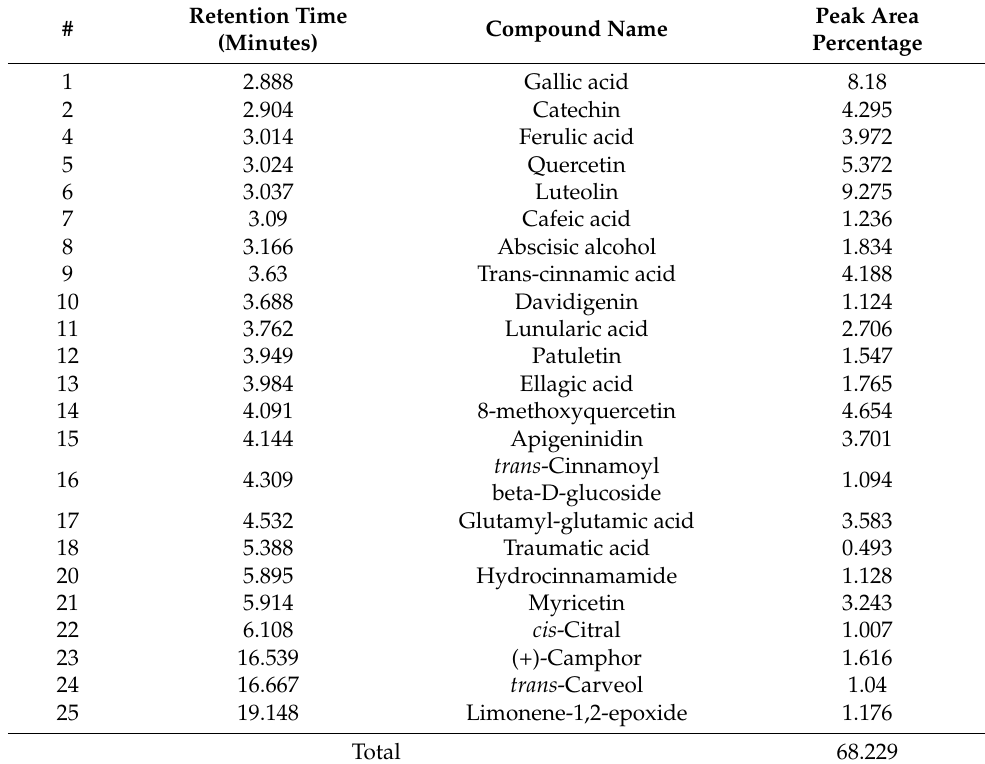
Table 1. Some of the chemical constituents identified in the aqueous extract of CARD after the LC-TOF-MS